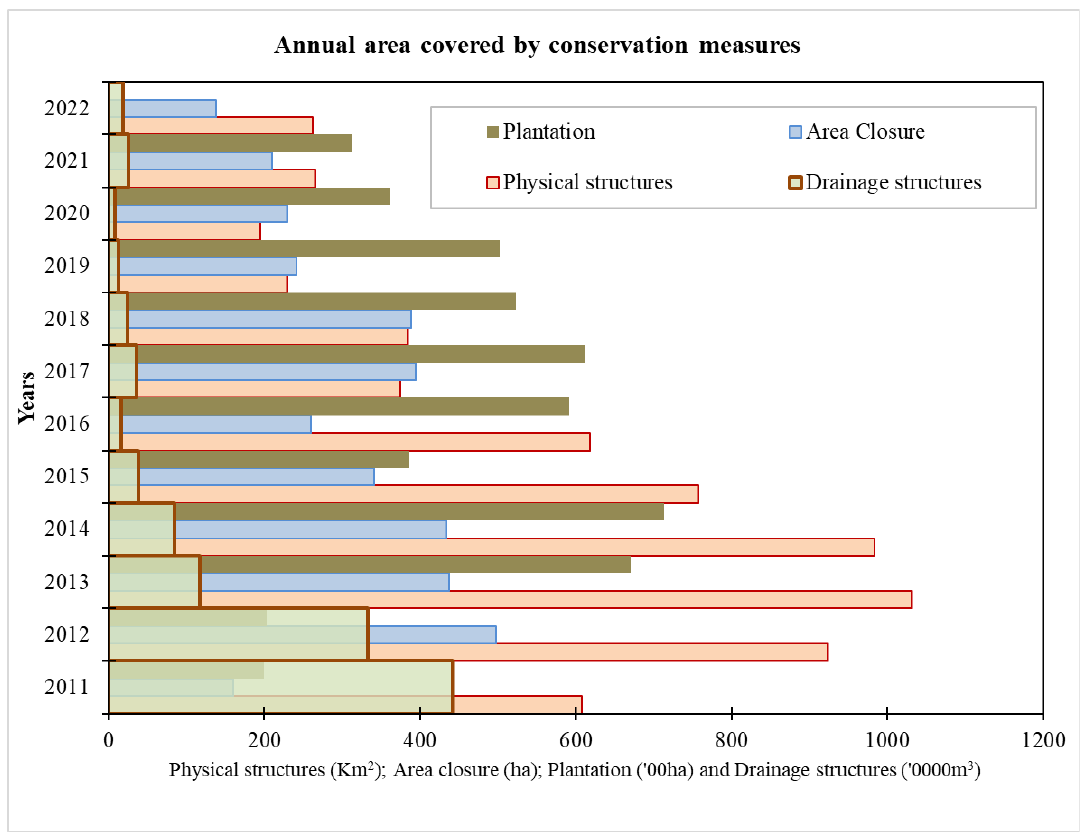
Land 2022 , 11 , x FOR PEER REVIEW 9 of 14 Figure 3. Annual biophysical conservation measures over the twelve-year period in the zone.